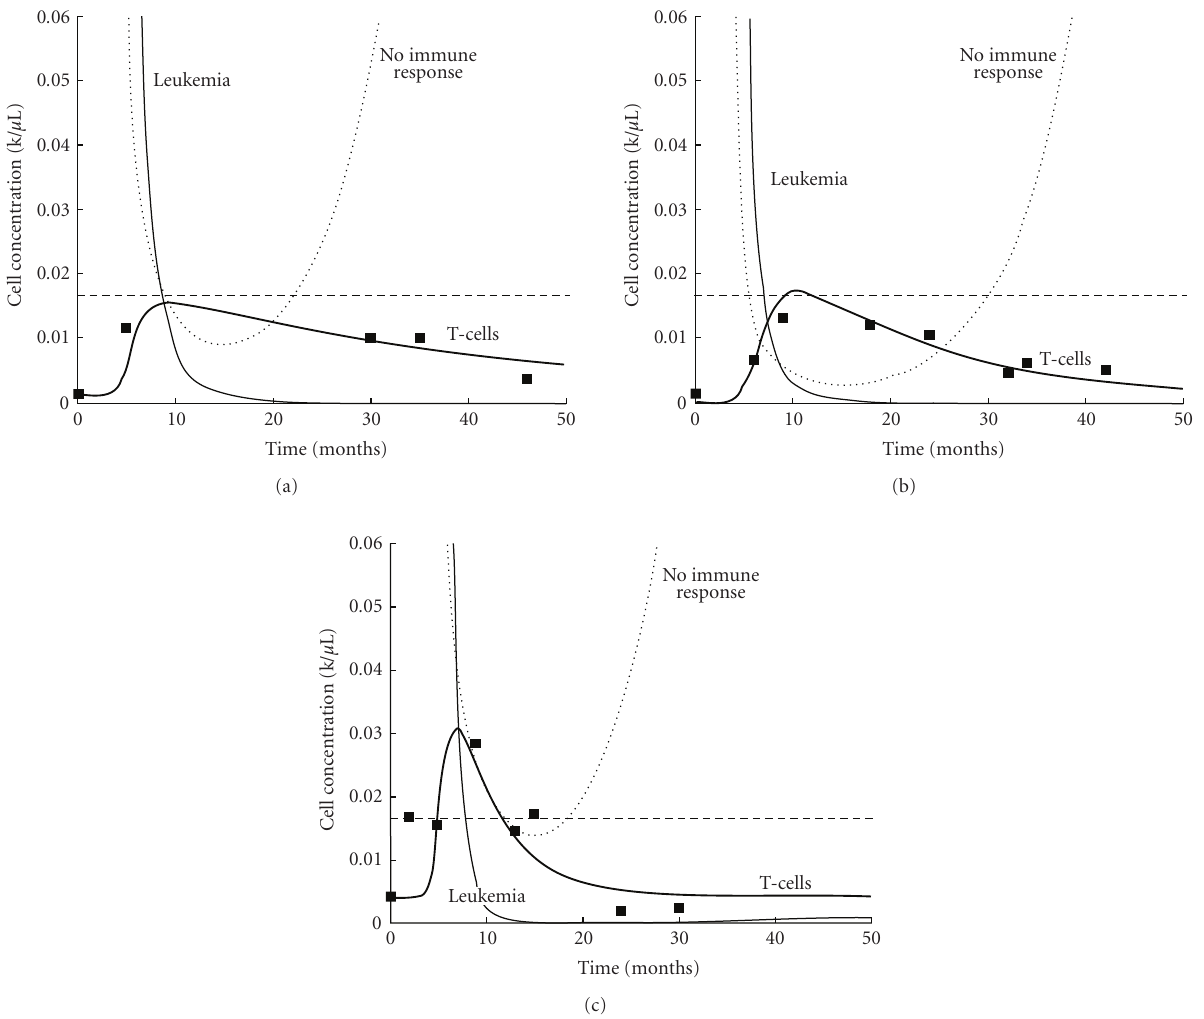
Figure 5: Di ff erential equations model validation with experimental data of chronic myelogenous leukemia treatment with imatinib [44]. (a), (b), and (c) show data from di ff erent patients along with simulated results using individual parameters for each of the patients. Simulated cell concentrations are compared to measurements of T-cell numbers from [53] (cell numbers are scaled down by 2500 to show relative magnitudes). Simulated curves are shown as lines and experimental data as black squares; the horizontal dashed line indicates the approximate level of complete cytogenetic remission. “No immune response” corresponds to the predicted tumor cell number using a model that does not include the immune response [54], “Leukemia” corresponds to the results of another model that takes the immune response into account [44]. The “T cells” curve is obtained with the model by Kim et al. and is compared to experimentally observed T-cell numbers from di ff erent patients